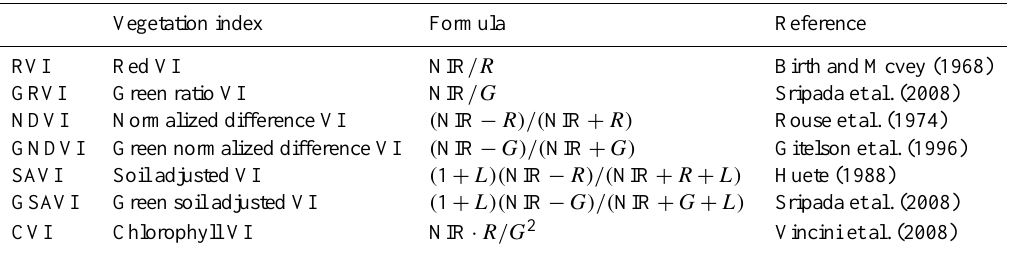
Table 1. Overview of the VIs used in this study. NIR, R , and G stand for the spectral reflectance in the near-infrared, visible red and visible green frequencies. L is a scaling constant (here L = 0 .